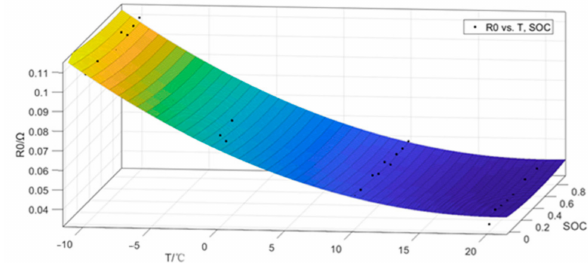
Figure 6. R 0 - T - SOC fitting results at low temperature.